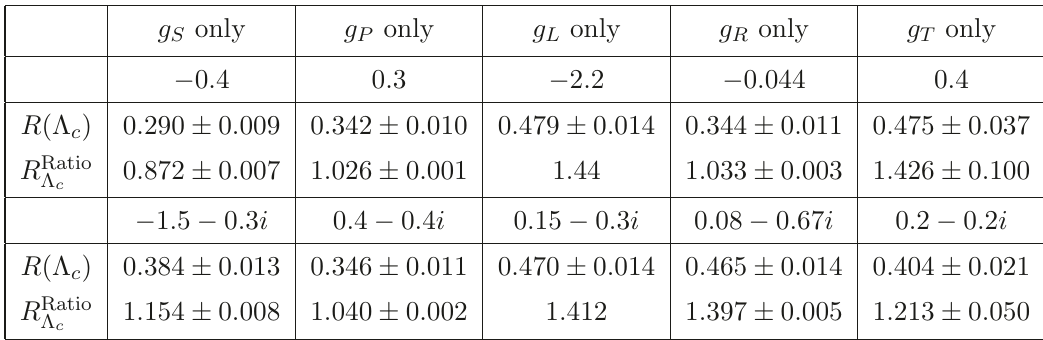
Table 3 . The values of R (Λ c ) and R Ratio valued) of the new-physics couplings. The standard-model value of R (Λ c ) is 0 . 333 uncertainties given are due to the form factor uncertainties.